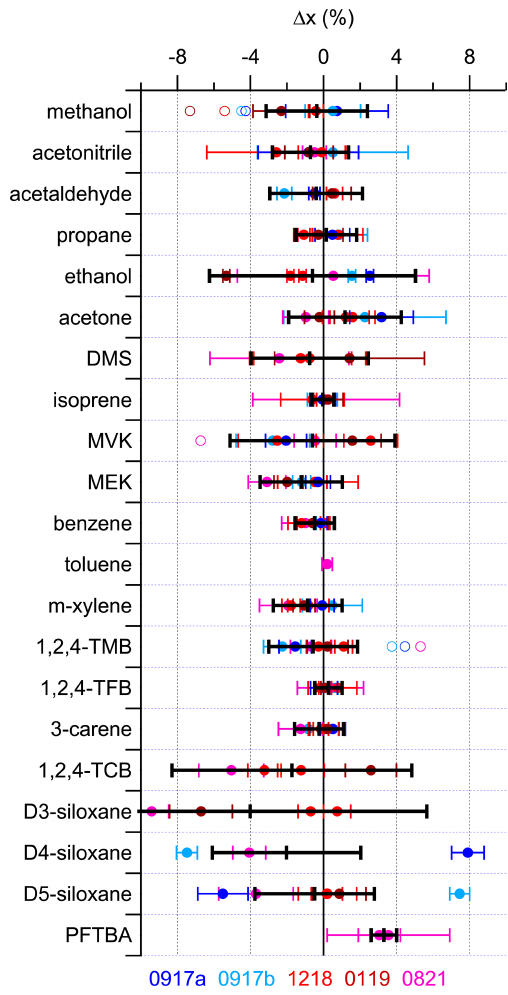
Figure 2. Relative difference ( (cid:49)x) using the FID data (except ace- tonitrile, which uses the MS data) for all components in five of the PRMs (0917a, 0917b, 1218, 0119 and 0821) relative to PRM 0819 (solid symbols). The solid black line represents the average of these validations, with the error bar representing the associated expanded uncertainty (2 σ) . For D4- and D5-siloxane, the averages do not in- clude the validations from 0917a or 0917b. Methanol and acetalde- hyde data are from the Cryo-GC-FID instrument, while all others are from the GC-FID/MS instrument. Open symbols represent the original data before correcting for biases observed in three of the parent mixtures (A410, 5% low for methanol; 3070, 6.3% low for MVK; D711530, 6% low for 1,2,4-TMB). PFTBA and toluene were only included in the most recently prepared PRM (0821) and are not present in 0819. Their validation is described in the text. Supporting validation data from all the MS and FID